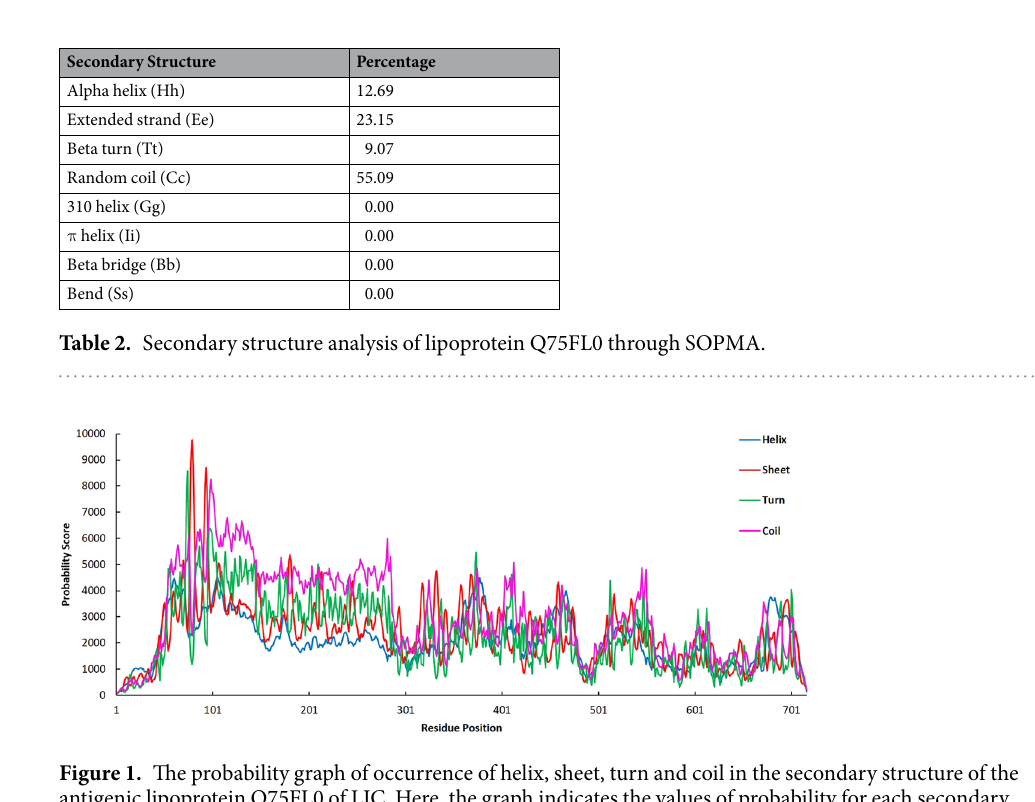
Table 1. Different physico-chemical properties of lipoprotein Q75FL0 of LIC.